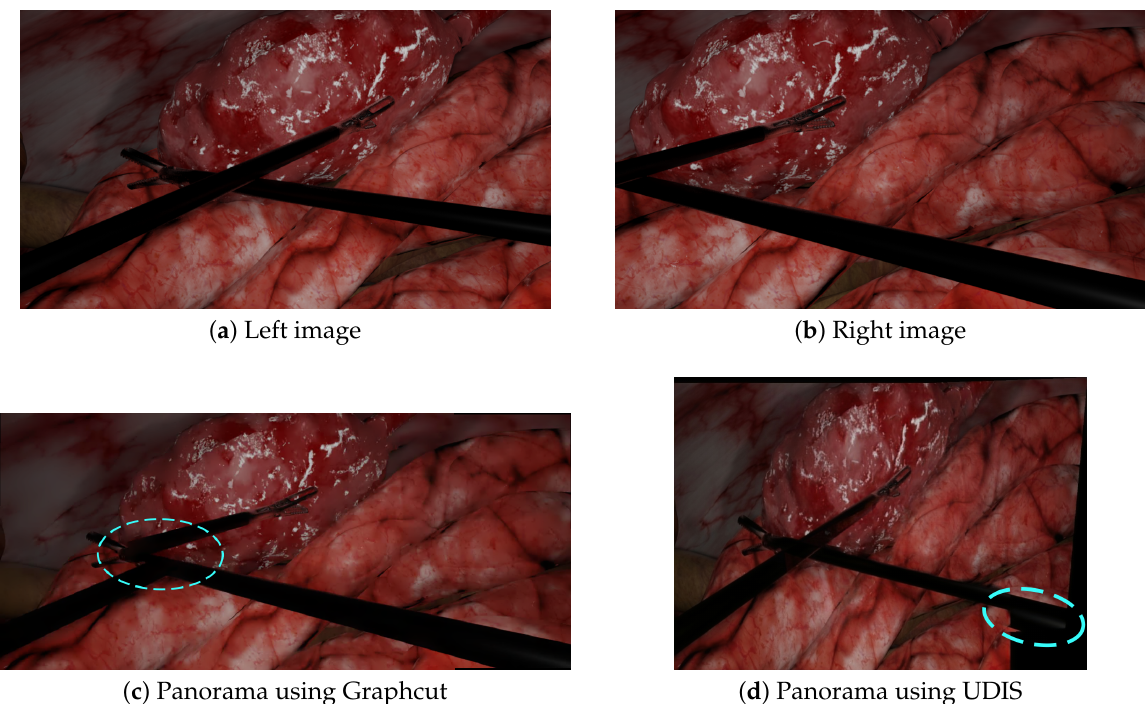
Figure 7. A complex scenario with crossed tools: the left ( a ) and right ( b ) images were stitched to- gether by Graphcut and UDIS. ( c ) With Graphcut, discontinuities appeared when the tools intersected in the input images. ( d ) With UDIS, a duplicated pair of forceps appeared in the bottom right corner. The main results are summarised in Table 3. Table 3. The main limitations of the image stitching algorithms within a laparoscopic context. The most important obstacles to clinical use are highlighted in the red box. Dash-underlined methods are those already employed with multi-camera